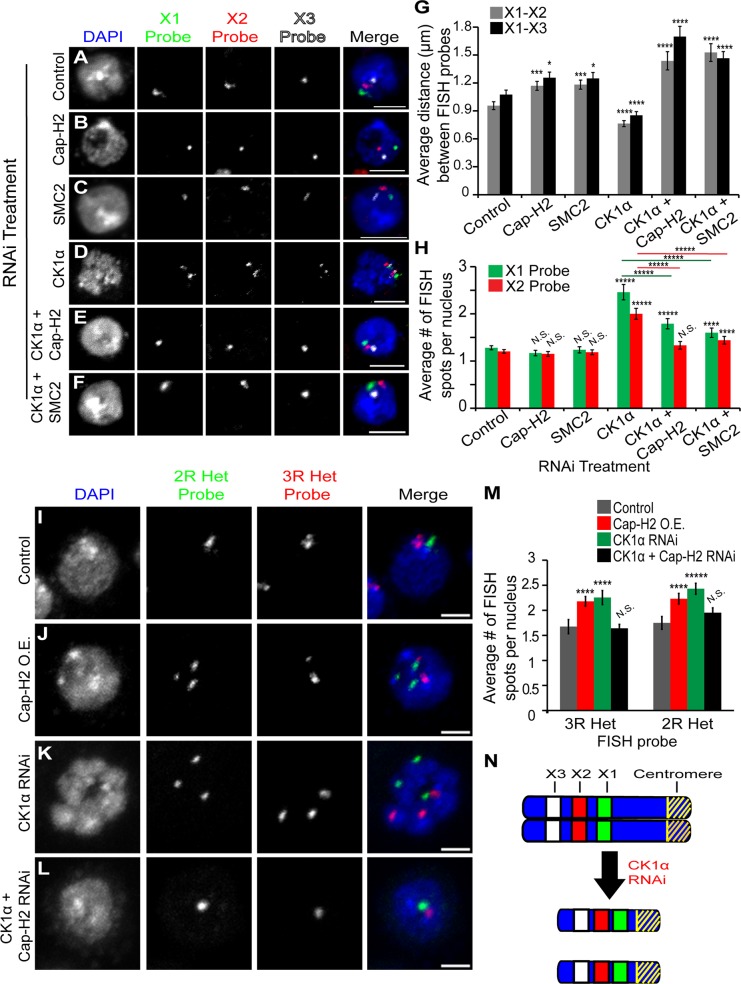
CK1α depletion increases chromosome compaction and unpairing activity in Kc cells.(A-F) Micrographs of RNAi treated Kc cells stained for DAPI (blue) and three different euchromatic FISH probes specific for the X chromosome (green, red, and white). Single FISH spot for each probe signifies that the homologs are paired and multiple FISH spots indicate the unpairing of chromosomes. Scale, 5μm. (G) Histogram showing the average 3D distance between pairwise FISH spots in microns in RNAi treated Kc cells (n = 45–100 cells per treatment). CK1α RNAi significantly reduces the distance between FISH spots, and this reduction is suppressed by double RNAi of CK1α + Cap-H2 or CK1α + SMC2. (H) Histogram showing the average number of FISH spots per nucleus in RNAi depleted Kc cells (n = 50–110 cells per treatment). CK1α RNAi significantly increases the number of FISH spots, and this increase is suppressed by double RNAi of CK1α + Cap-H2 or CK1α + SMC2. (I-L) Micrographs of RNAi treated Kc cells stained with FISH probes specific to heterochromatin on Chromosome 2R (green) and 3R (red) and counterstained for DNA (DAPI, blue). Cap-H2 overexpression (J) and CK1α depletion (K) induces unpairing of heterochromatin, which is suppressed by double RNAi of CK1α + Cap-H2 (L). Scale, 2.5μm. (M) Histogram showing average number of heterochromatin FISH spots per nucleus after RNAi depletion of the indicated protein. CK1α depletion results in a significant increase in number of FISH spots; (n = 40–78 cells per treatment). (N) Diagram of X chromosomes. Blue represents the DNA, yellow diagonal stripes represents the centromere, and green (X1), red (X2), and white (X3) rectangles represent FISH probes used for compaction and unpairing experiments. Depletion of CK1α via RNAi results in compaction and unpairing of chromosomes. N.S. = No significance. p-value = * < 0.05, ** < 0.01, *** < 0.005, **** < 0.001, ***** < 0.0001 (calculated by using students’ t-test in Microscoft excel). Error bars in all figures indicate SEM. (A-F,I-L) Maximum projection image of multiple z-slices.